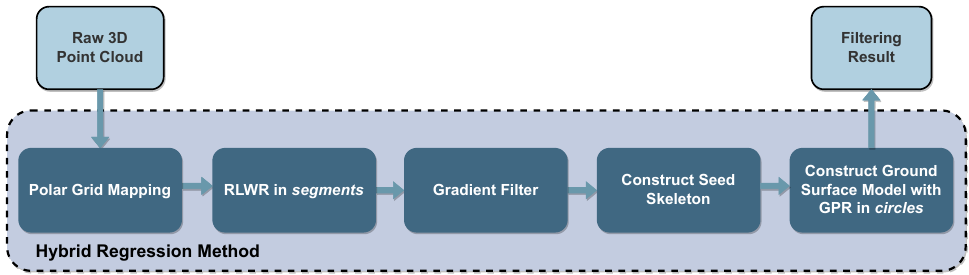
Figure 10. Hybrid Regression Method.